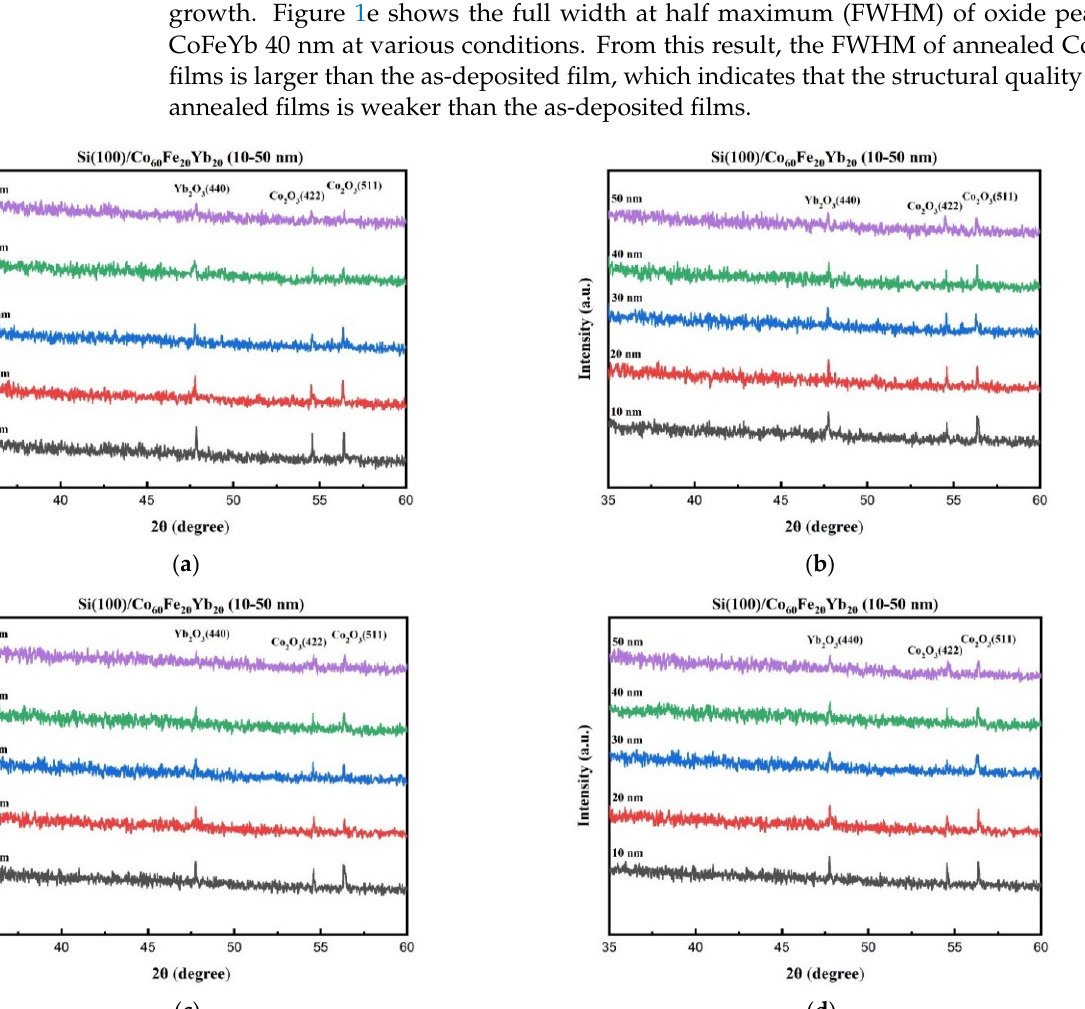
( e ) Figure 1. XRD patterns of CoFeYb films. ( a ) RT, ( b ) after annealing at 100 °C, ( c ) after annealing at 200 °C, ( d ) after annealing at 300 °C. ( e ) FWHM of oxide peaks in CoFeYb 40 nm at various condi- tions. 3.2. Magnetic Property Figure 2a–d shows that χ ac has a thickness of 10 to 50 nm at room temperature as well as at 100, 200 and 300 °C. In the low frequency range of 50–25,000 Hz, χ ac decreases as the frequency increases. The results also show that when the thickness is from 10 to 50 nm, χ ac is increased.